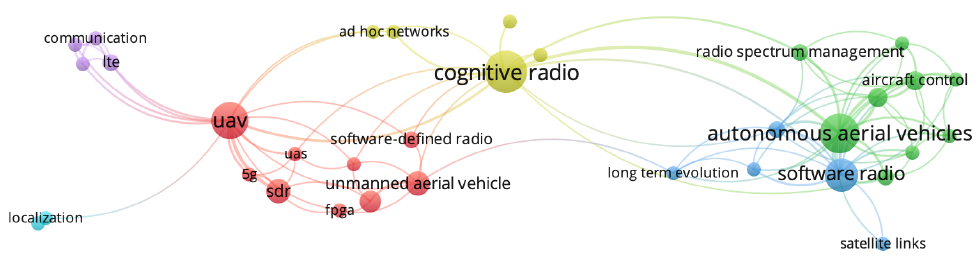
Figure 12. Keywords graph and occurrence mapping for all 64 articles selected on this